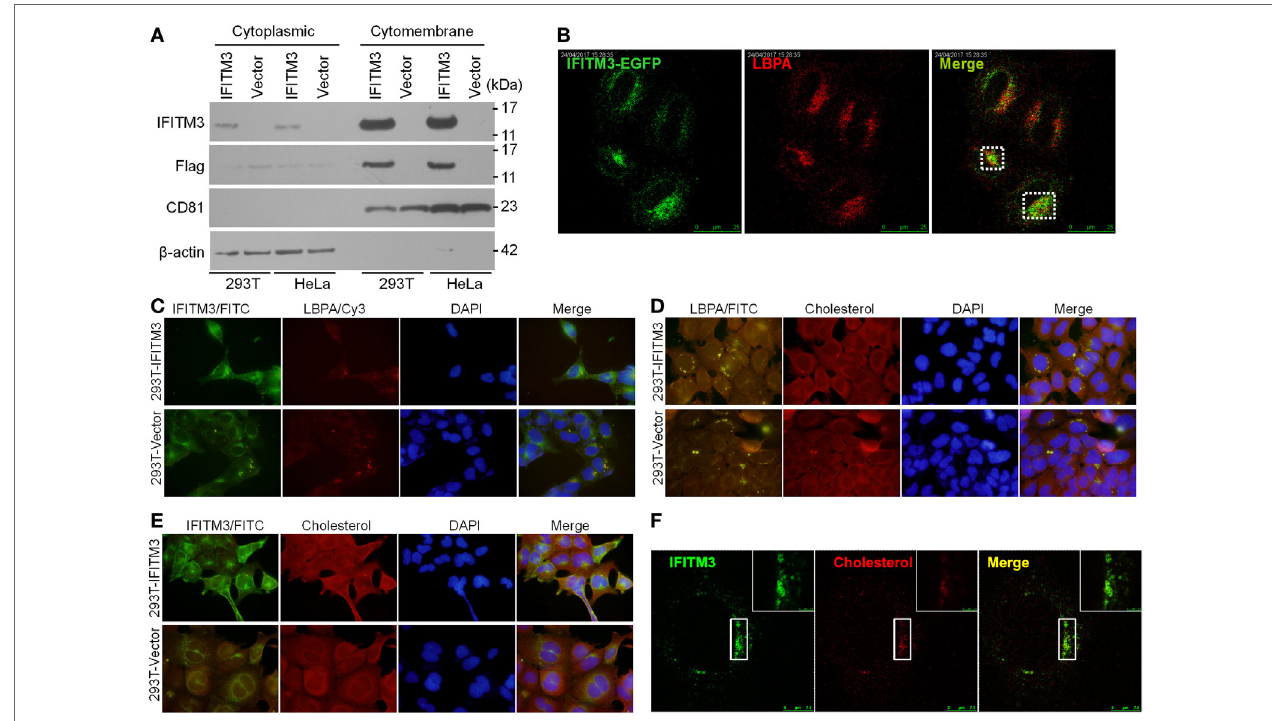
FigUre 7 | Cellular distribution and localization of interferon-inducible transmembrane protein 3 (IFITM3) protein. (a) Cellular distribution of IFITM3 expression in membrane or cytoplasm measured by Western blot analysis following the separation of membrane proteins and plasma proteins of IFITM3 + 293T and HeLa cells. CD81 and β -actin were selected as the marker of membrane and cytoplasm proteins, respectively. (B) IFITM3 localizes in LBPA + late endosomes evaluated by confocal microscopy. HeLa cells transfected with IFITM3-EGFP expression plasmid for 36 h were stained with mouse monoclonal anti-LBPA followed by a Cy3-conjugated antimouse IgG. (c–F) IFITM3 partially localizes in Cholesterol + late endosomes. IFITM3 + 293T cells were stained with rabbit anti-IFITM3 and mouse monoclonal anti-LBPA followed by a FITC-conjugated anti-rabbit IgG and Cy3-conjugated anti-mouse IgG, and cholesterol was traced with Amplex ® Red Cholesterol Assay Kit. IFITM3 and LBPA, IFITM3 and cholesterol, or LBPA and cholesterol colocalization is evaluated by fluorescence microscope or confocal microscopy. Nucleus is stained with